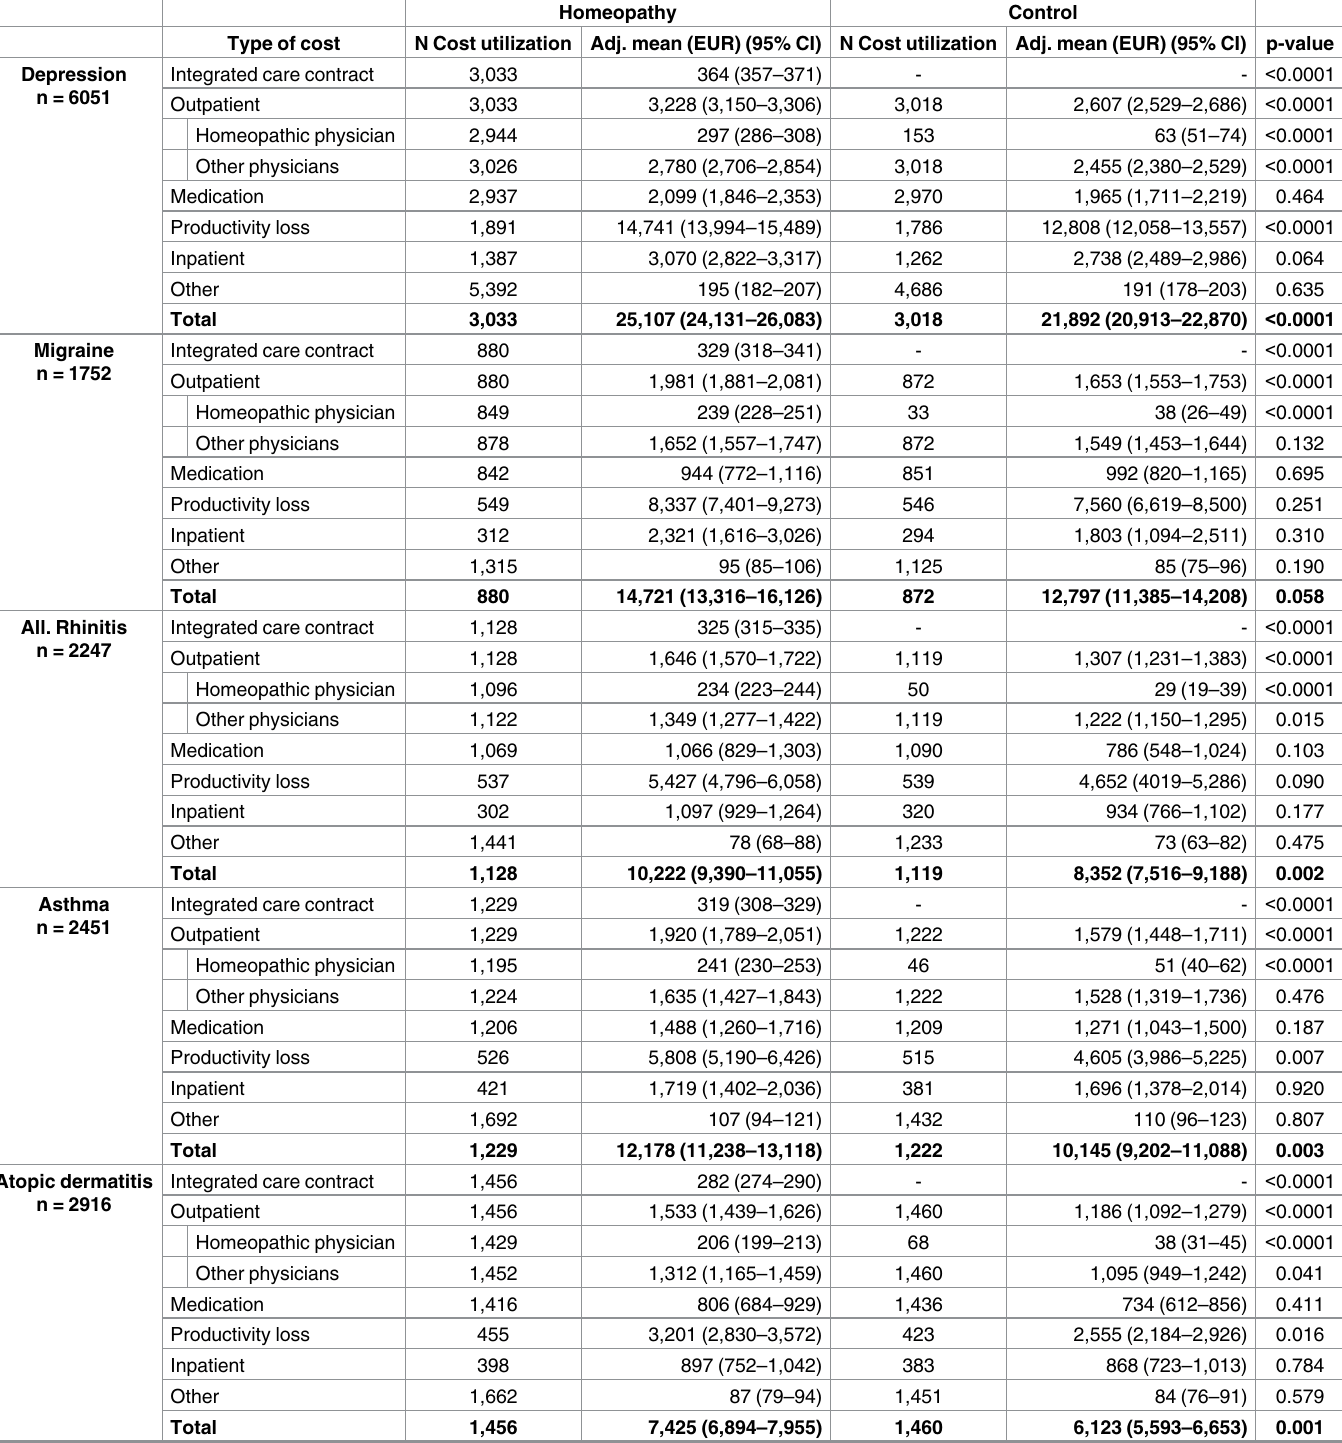
Table 3. Adjusted means for different cost types and diagnoses over 33 months after the beginning of the integrated care contract, societal perspective. Homeopathy